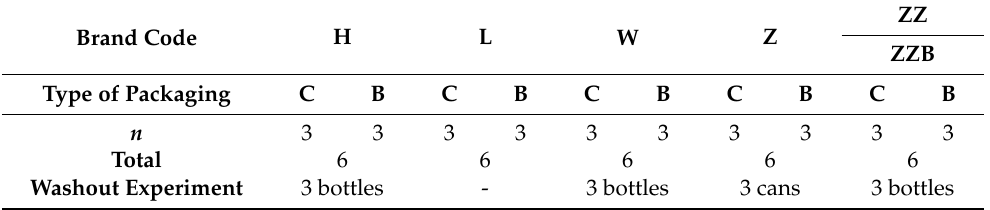
Table 3. Basic characteristics of the investigated beer samples according to type of packaging. Brand